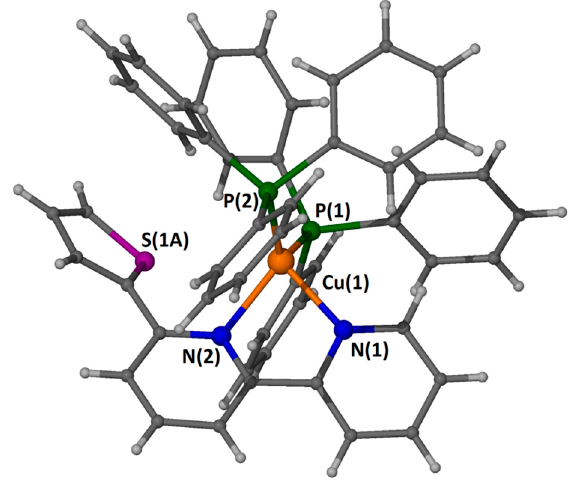
Figure 5. A “ball and stick” presentation of the cation in compound 1 with a partial labeling scheme. Only one part of the thiophenyl moiety is shown for clarity.